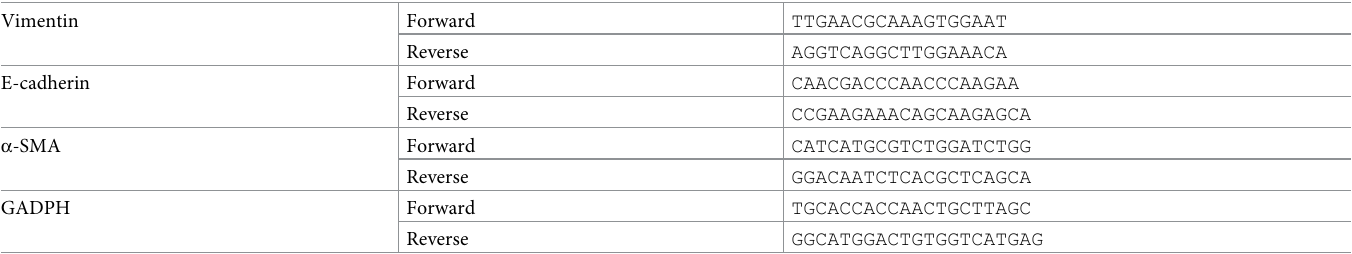
Table 1. Primers designed for different target